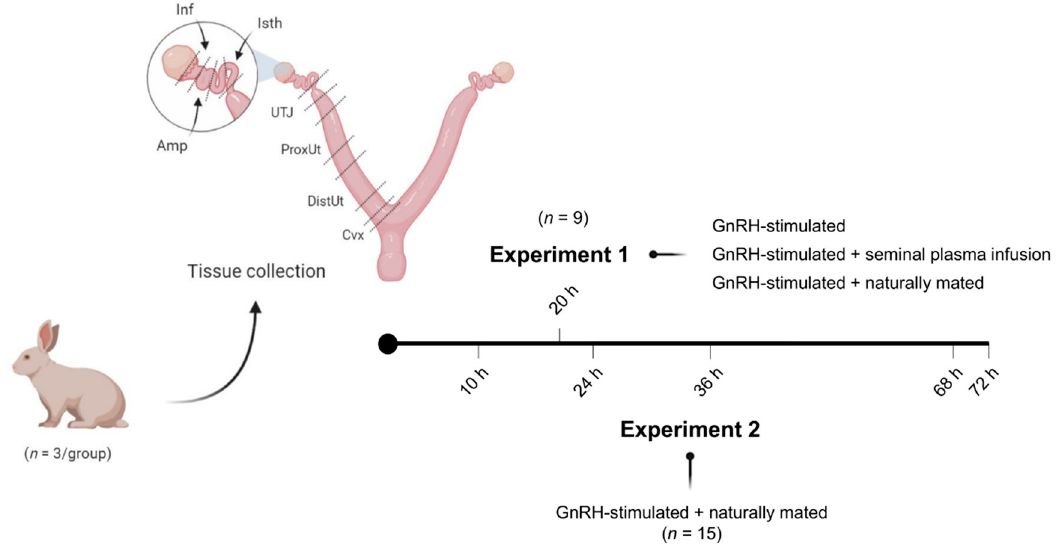
Figure 1. Representation of the experimental design and tissue sections obtained from does. Sequential tissue segments derived from does: endocervix (Cvx), distal uterus (DistUt), proximal uterus (ProxUt), utero-tubal junction (UTJ), isthmus (Isth), ampulla (Amp), and infundibulum (Inf). Intramuscular injection of 0.03 mg gonadotropin-releasing hormone (GnRH) was used to induce ovulation in all groups of both experiments.